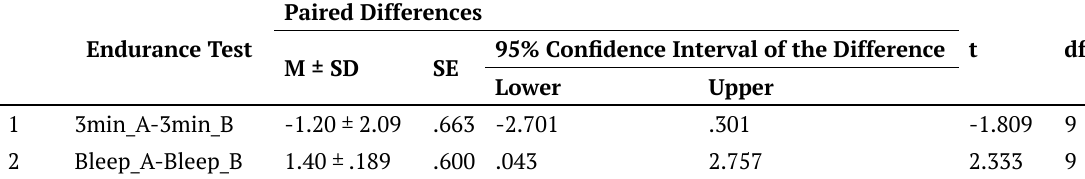
Table 4. Gender in terms of Endurance Level